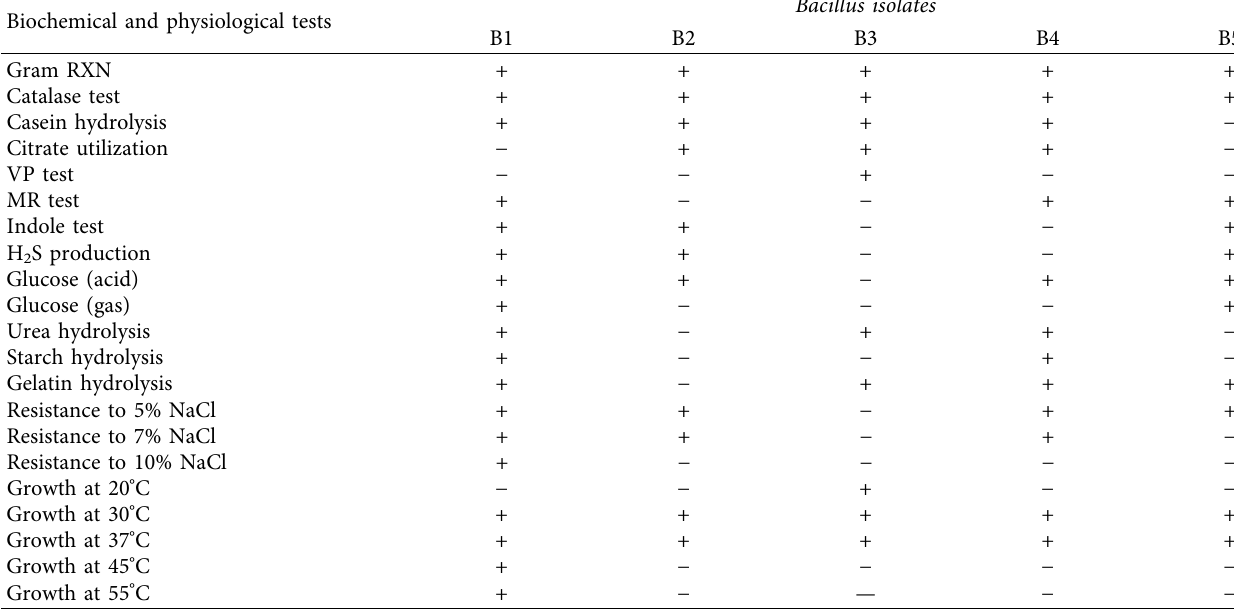
Table 2: Physiological and biochemical characteristics of Bacillus isolates recovered from Lake Tana sediment